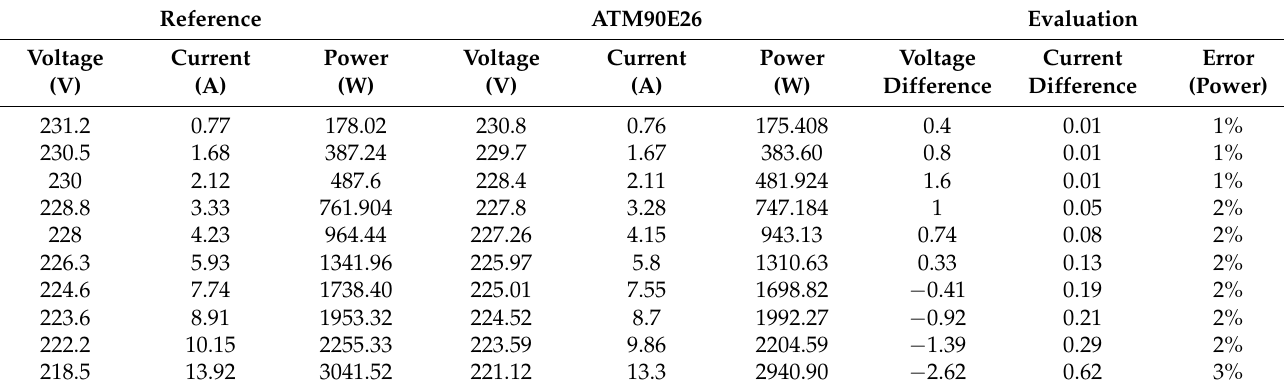
Table 3. Measurement after calibration performed with the YHDC SCT-013-010